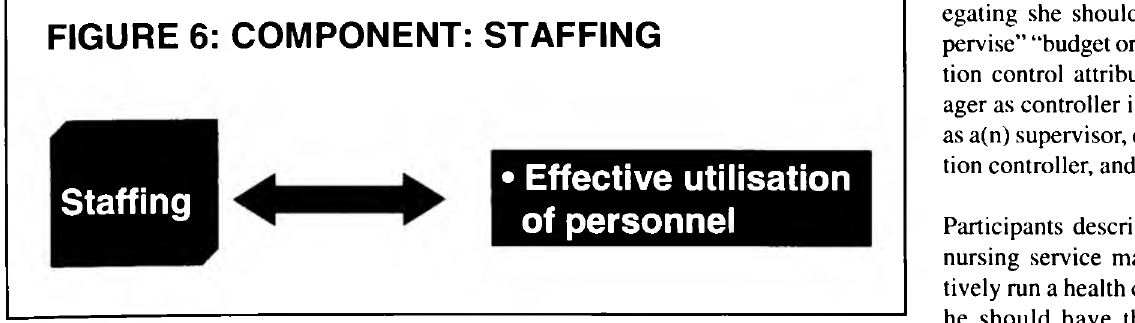
FIGURE 6: COMPONENT: STAFFING